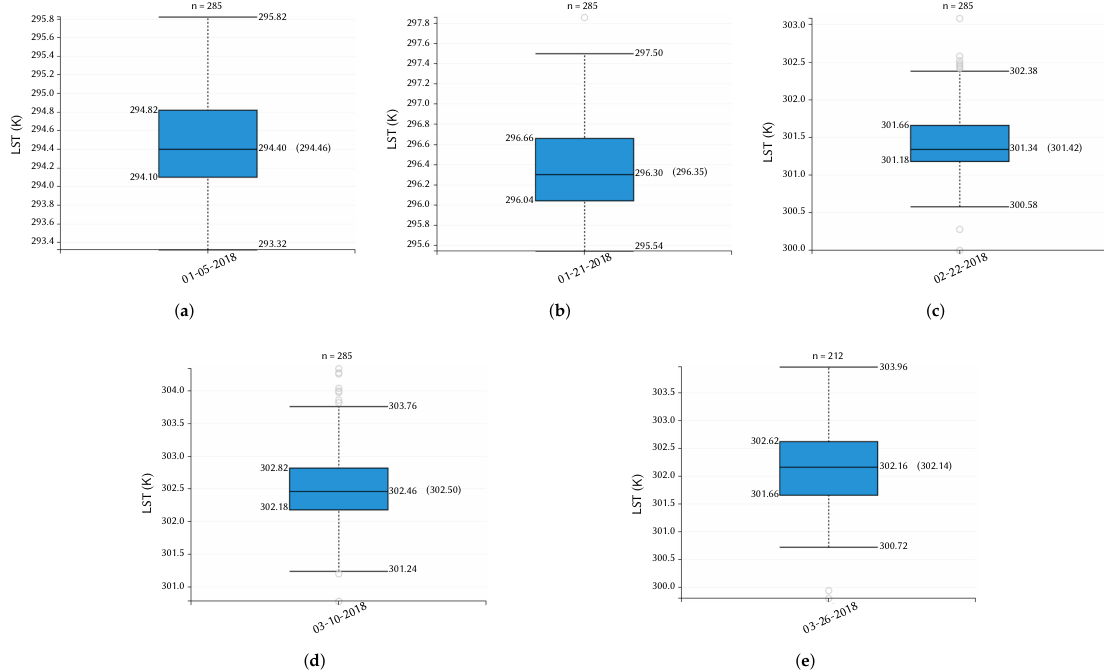
Figure 12. Box plots representing daily LSTs retrieved from the Terra MODIS images of different dates: ( a ) 5 January 2018 image, ( b ) 21 January 2018 image, ( c ) 22 February 2018 image, ( d ) 10 March 2018 image, and ( e ) 26 March 2018 image. The parameter n indicates the total number of values/pixels; the boxes show the interquartile range (IQR) along with median, mean (in parentheses) values; the whiskers represent the lowest and highest datum within 1.5 IQR of the lower- and upper-quartile, respectively (all LST values are in K unit). Table 8. Cross-validation and intercomparison results of Landsat 8 LSTs retrieved with four algorithms and with the Atmospheric and Topographic CORection (ATCOR) module against Terra MODIS